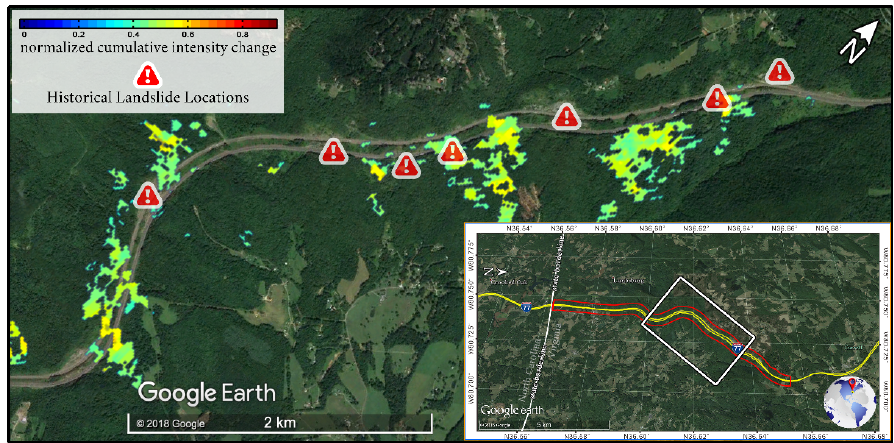
Figure 8. The normalized cumulative intensity change map for ERS-1&2 descending track 97 from 1992 to 2000 and the reported historical landslides